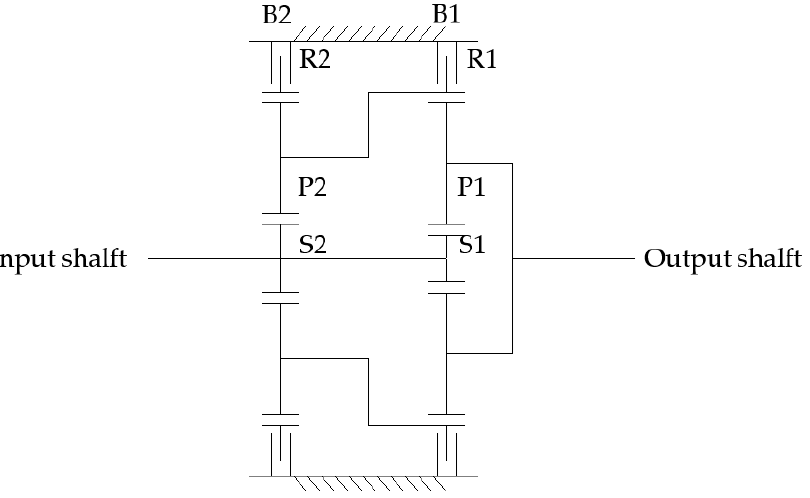
Figure 3. Planetary gearbox. Table 1. Transmission control